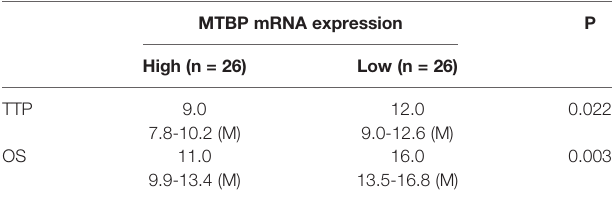
TABLE 4 | MTBP expression and clinical outcome of patients received sorafenib